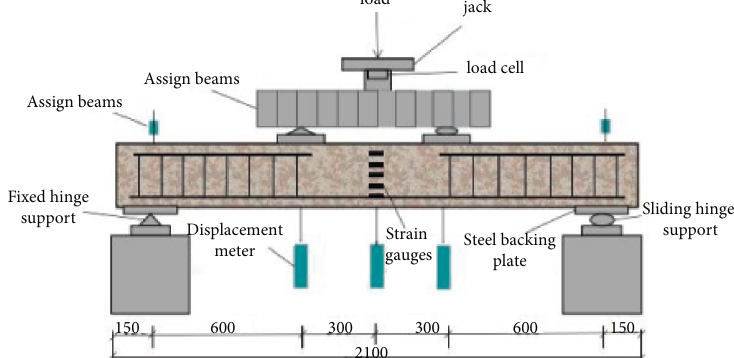
Figure 3: Lading point layout.